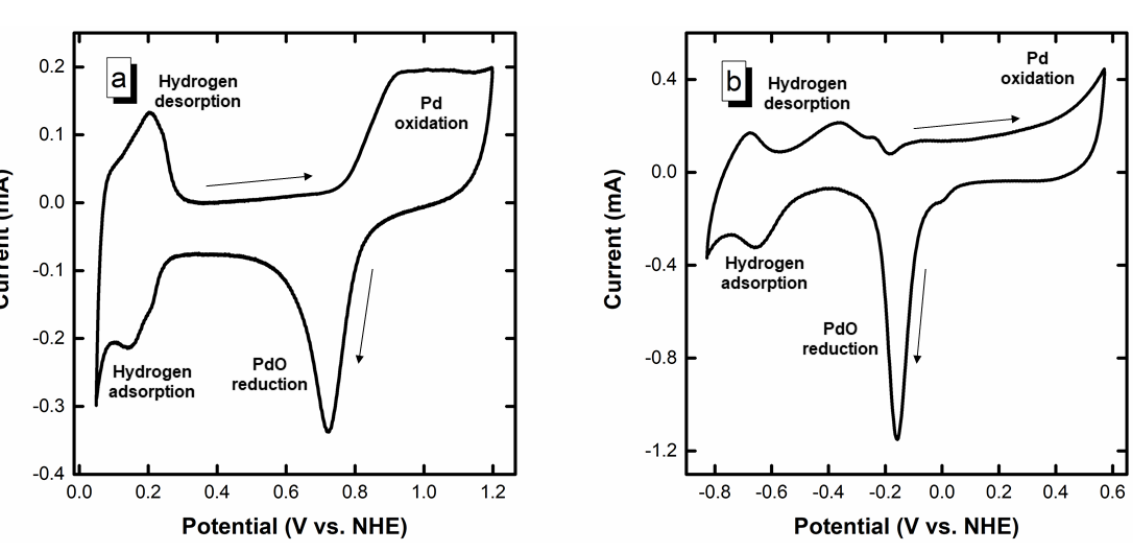
Figure 1. ( a ) Blank CV in 0.5 mol L − 1 H 2 SO 4 , and ( b ) Blank CV in 1 mol L − 1 NaOH. Arrows indicate the direction of the potential